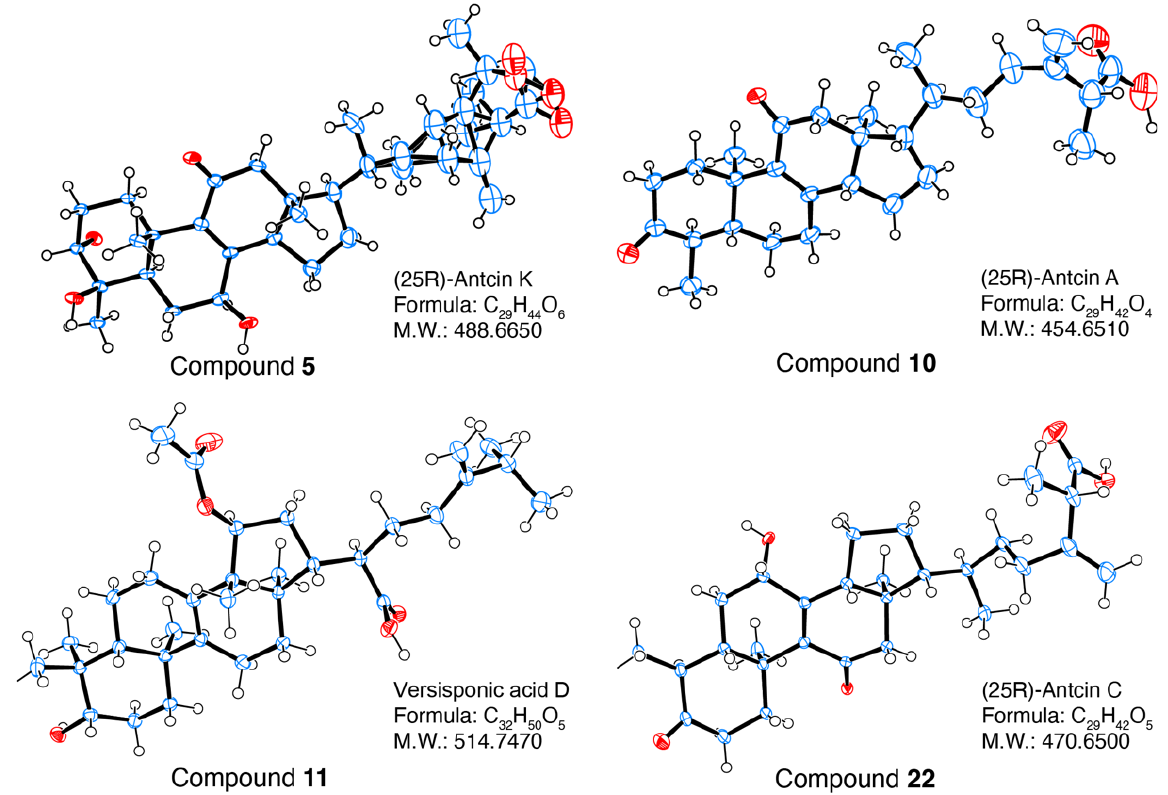
Figure 4. ORTFP drawing of 5 , 10 , 11 and 22 .